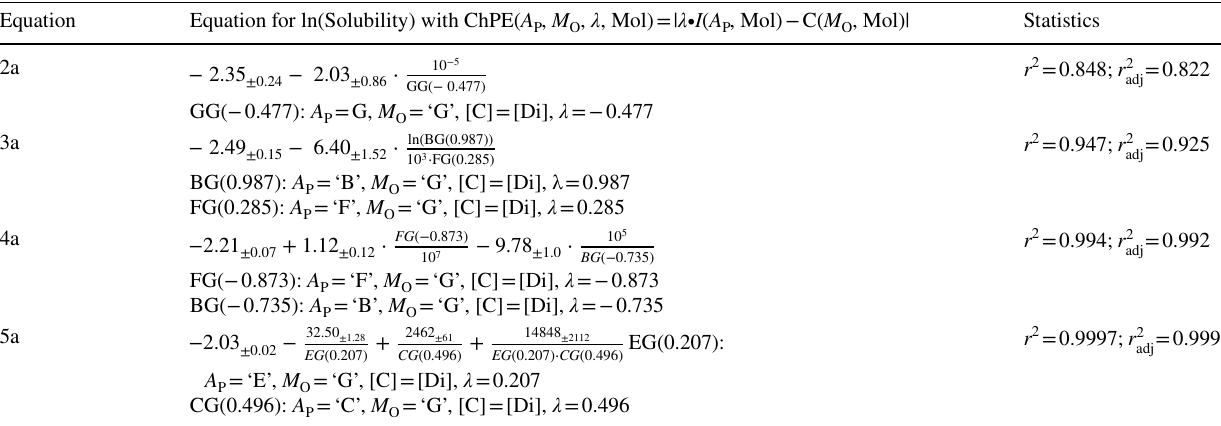
Table 6 Models with the best explanatory power for solubility of monosaccharides